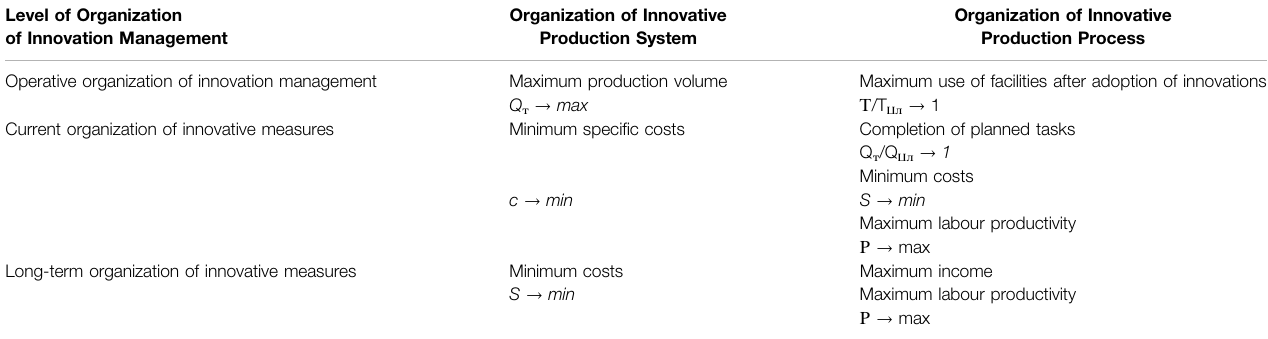
TABLE 4 | Optimality criteria in innovation management for organizational